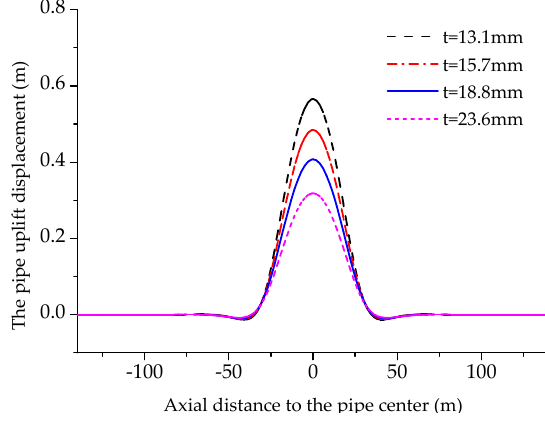
Figure 14. Vertical deformations for pipes with various wall thicknesses.